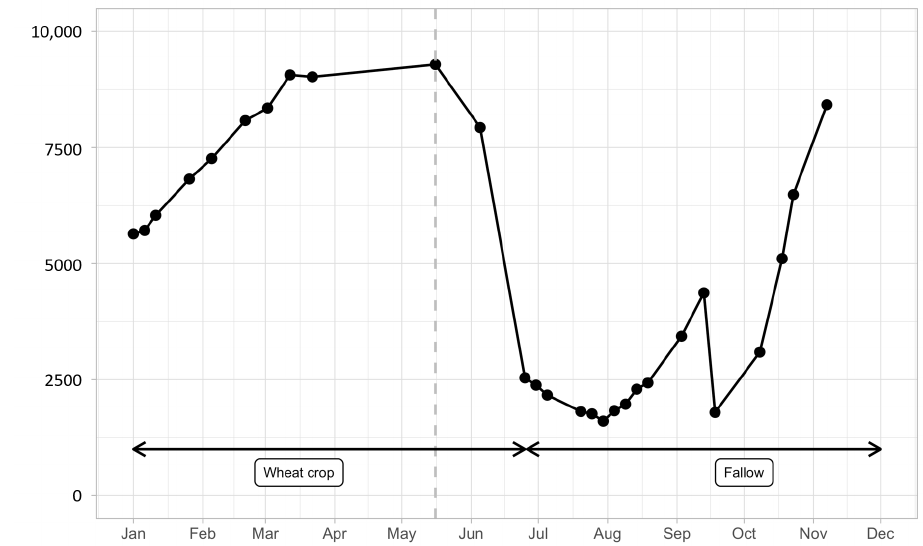
Figure 3. Average NDVI profile for 2019 in the study area. Dots are NDVI values averaged over the study area on available S-2 date (i.e., not masked due to low QA metadata). Crop peak phase was detected to be on 16 May, vertical dashed